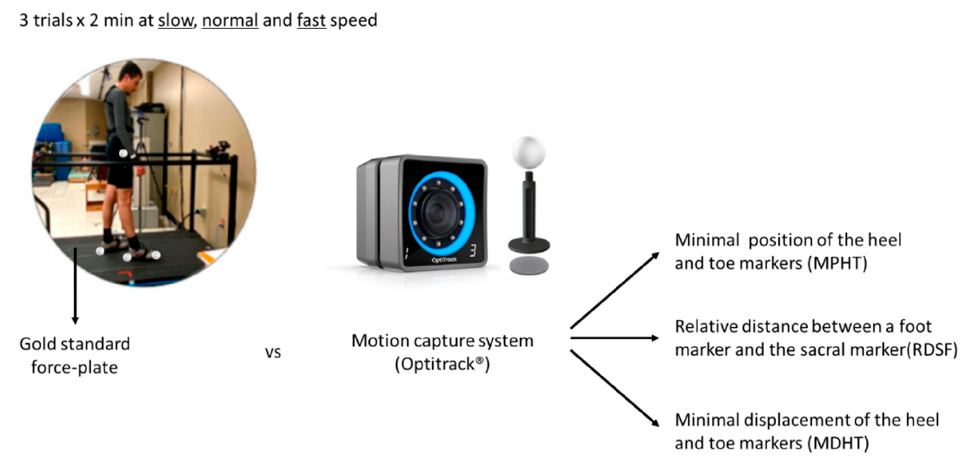
Figure 1. Study overview. Participants performed three 2 min treadmill walking trials at slow, normal, and fast walking speeds on a split-belt instrumented treadmill. Participants were instrumented with 16 passive markers on the lower body. Gait was simultaneously captured by both the treadmill force plates and the motion capture system. Gait events were then assessed using three different motion capture algorithms.